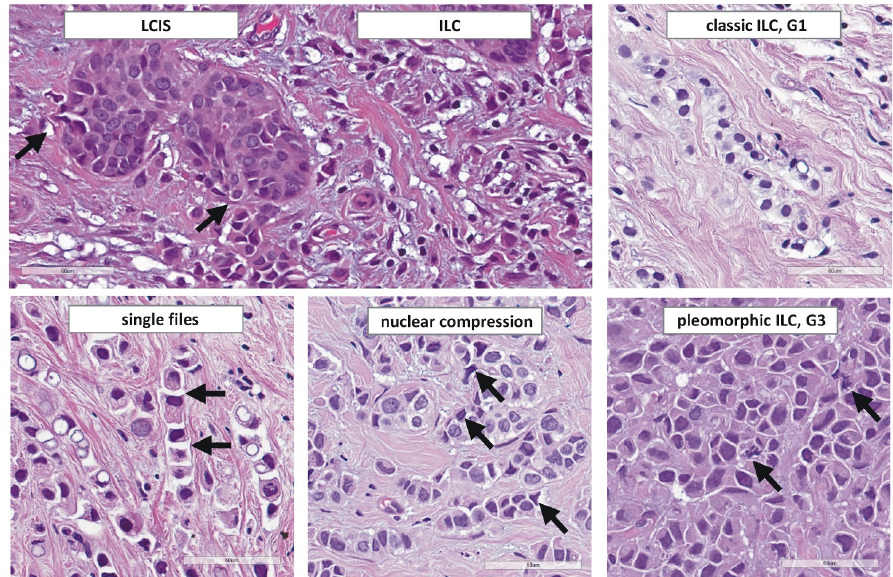
Figure 2. Histomorphology of ILC. From top left to lower right, photomicrographs (×400 magnification) illustrate: transition from LCIS to ILC (arrows indicate LCIS cells that breach through the basal lamina), classical ILC (G1), ILC arranged in single files with gaps between individual cells (arrows), ILC with prominent nuclear compression (arrows), pleomorphic ILC (G3) with brisk mitotic activity (arrows).